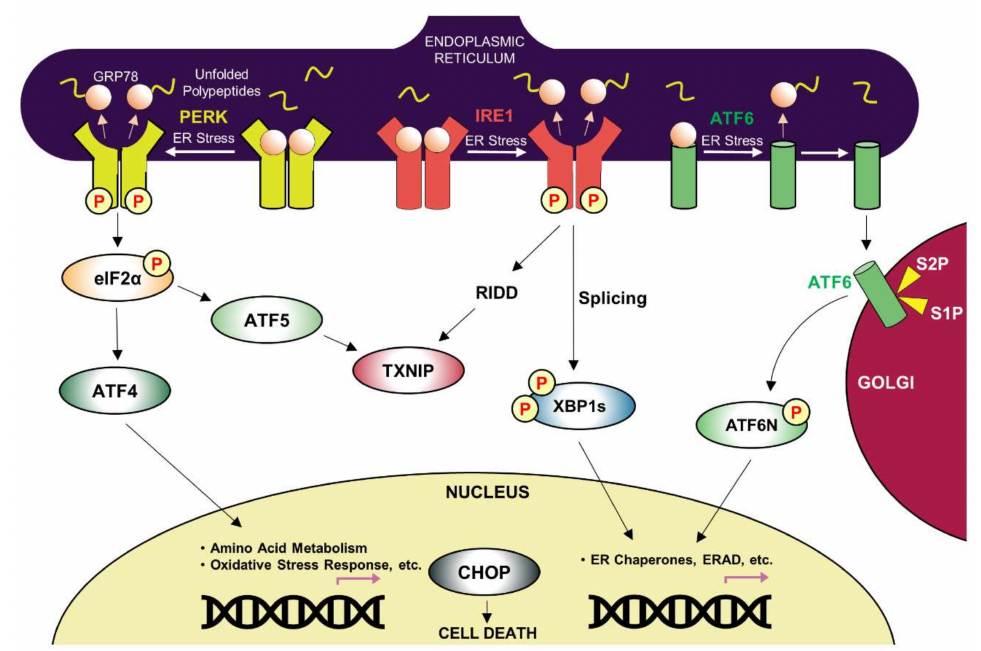
Figure 1. Summary of UPR signaling cascade. UPR is initiated by GRP78’s dissociation from UPR components on the ER membrane under ER stress. PERK and IRE1 undergo autotransphosphoryla- tion after their dimerization or oligomerization, and ATF6 is translocated to Golgi and cleaved by protease S1P and S2P. UPR activation enhances target gene expression to restore ER protein folding capacity or triggers cell death. TXNIP induced by PERK and IRE1 also activates the inflammasome and triggers subsequent cell